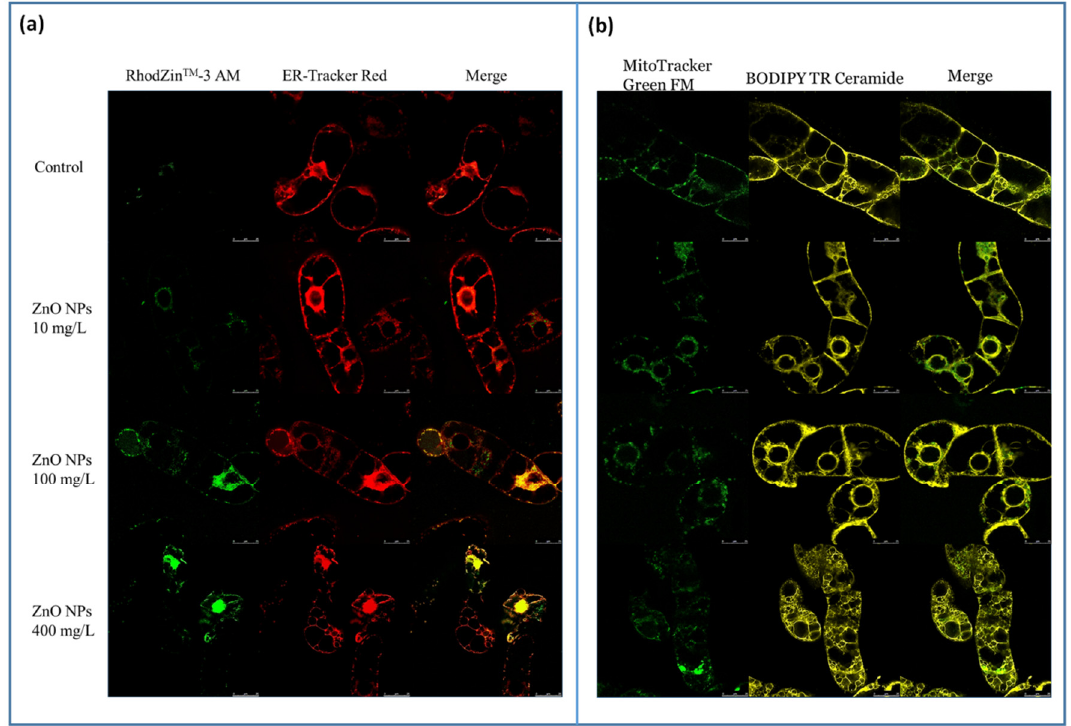
Figure 2. The effect of 0, 10, 100 and 400 mg/L ZnO NPs on BY-2 cells 72 h after the treatment. Visualization of intracellular zinc ions using RhodZinTM-3 AM ( a ). Endoplasmic reticulum was visualized by ER-Tracker Red ( a ), mitochondria by MitoTracker Green FM, and Golgi apparatus by BODIPY ® TR Ceramide ( b ). The length of bar represents 25 µm.